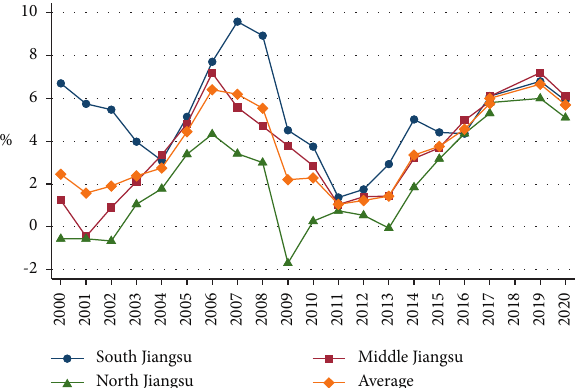
Figure 1: Variation diagram of TFP growth rate in regions of